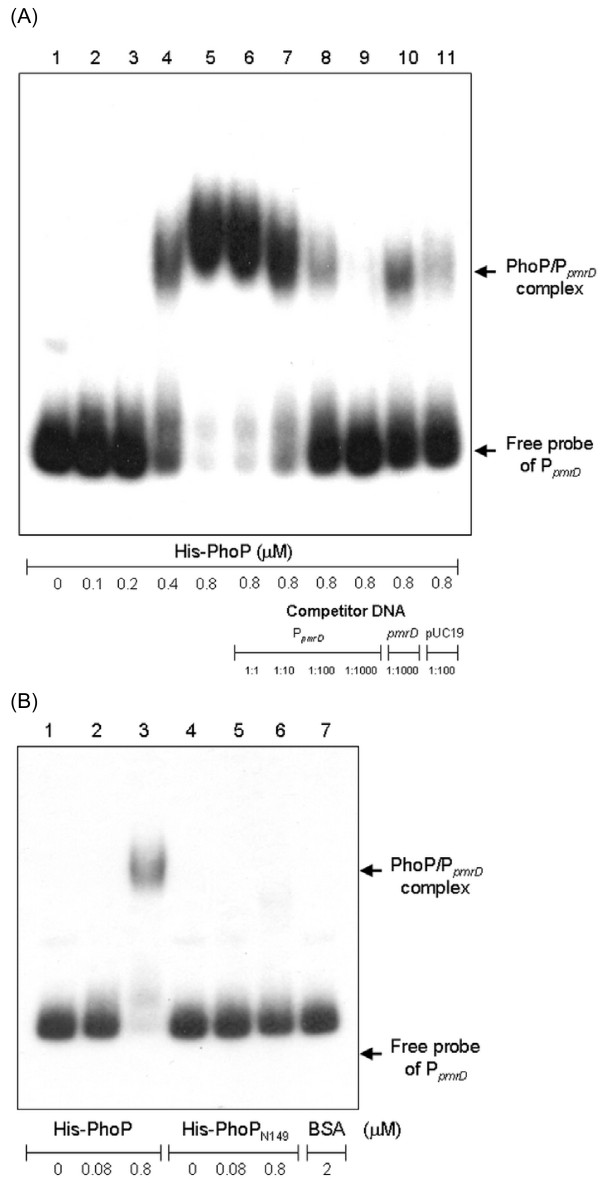
Binding of His-PhoP and His-PhoPN149 to PpmrD. (A) Specific binding of recombinant His-PhoP protein to the putative pmrD promoter. EMSA was performed by using the 32P-labeled DNA probe of PpmrD incubated with increasing amounts of the His-PhoP (lanes 2 to 5), with 40 pmole of His-PhoP plus increasing amounts of the unlabeled PpmrD DNA (specific competitor, lane 6 to 9), or with excess amounts of non-specific competitor DNA (lane 10 and 11). The amounts of recombinant proteins and DNA probes used are indicated in the figure. (B) EMSA was performed with 0, 4 or 40 pmole of His-PhoP (lanes 1 to 3), His-PhoPN149 (lanes 4 to 6) or 100 pmole of BSA (lane 7). The arrows indicate the PhoP/PpmrD complex and free probe of PpmrD.